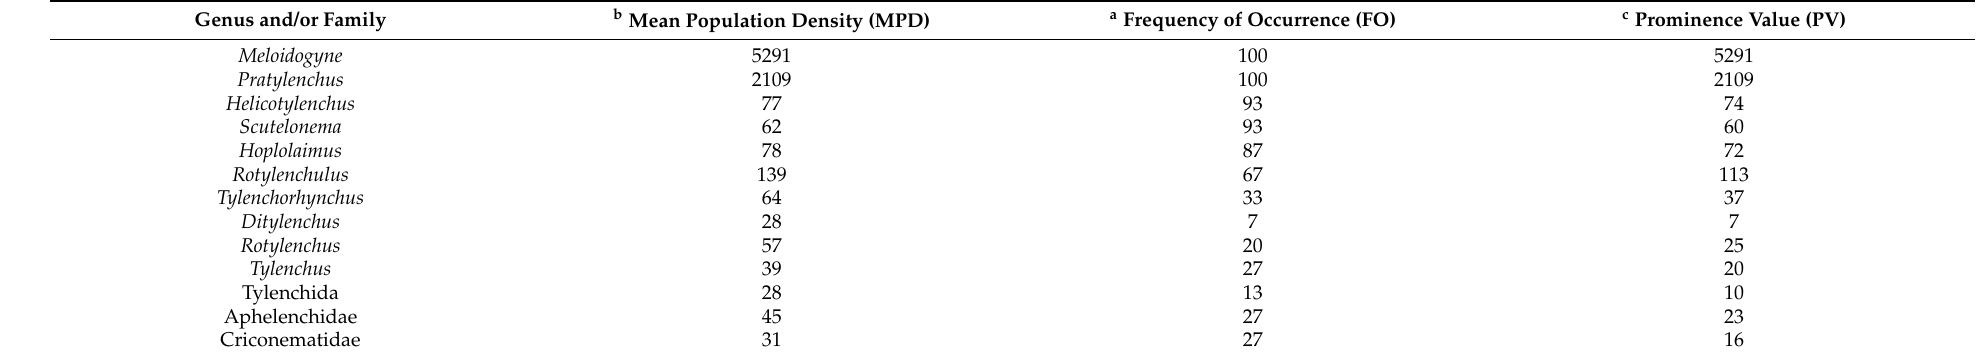
Table 2. Prominence values, frequencies of occurrence and mean population densities of plant parasitic nematode genera occurring in 20 g soybean root samples collected during the 2018/19 growing season from 15 fields of commercial producers in the Highveld region of the Mpumalanga province of South Africa. Genus and/or